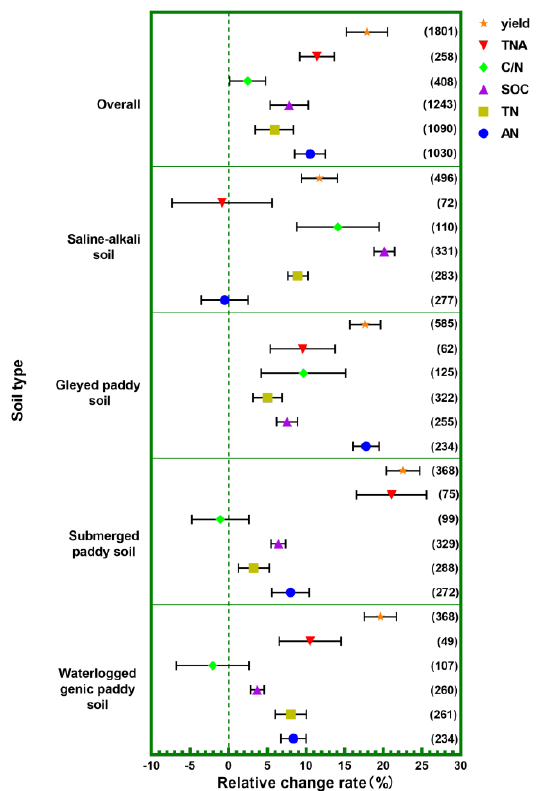
Figure 8. Relative change rates for different soil types. Description of symbols: AN, soil available nitrogen; TN, soil total nitrogen; SOC, soil organic matter; C:N, soil carbon−nitrogen ratio; and TNA, total N accumulation. Numbers in parentheses represent the effect value (lnR).